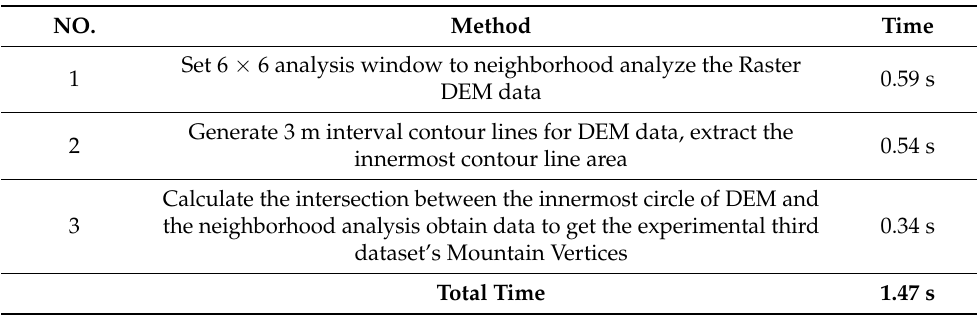
Table 12. The time spent in extracting mountain vertices for the third dataset using the Contour Line and Neighborhood Analysis Overlay